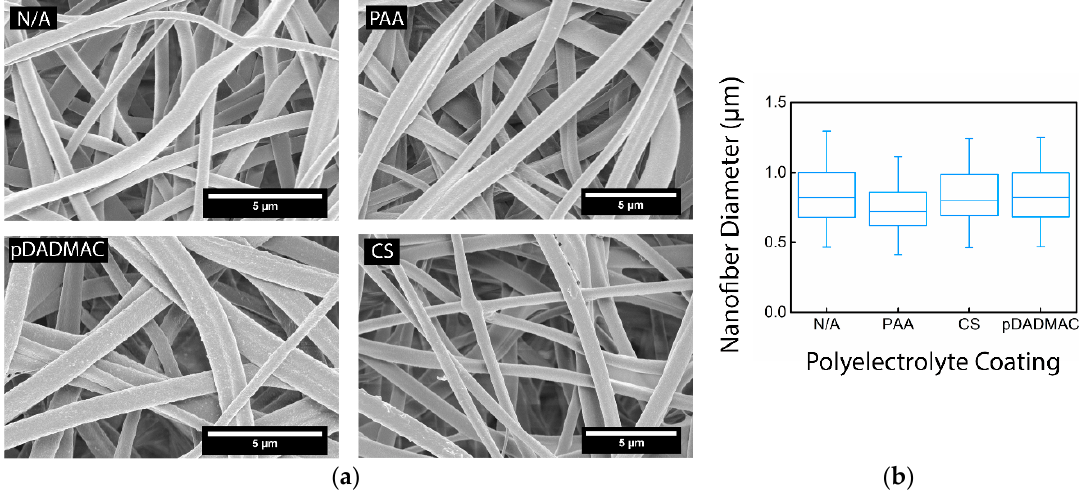
Figure 1. ( a ) SEM micrographs of electrospun cellulose nanofiber mats without functionalization (N/A) and functionalized with PAA, CS, and pDADMAC. All scale bars are 5 µm; ( b ) A box-and-whisker plot shows the median, lower and upper quartile, and the minimum and maximum value for the nanofiber diameter distribution for the cellulose nanofiber mats without functionalization (N/A) and functionalized with PAA, CS, and pDADMAC. All nanofiber mats had a statistically equivalent average fiber diameter. N = 3 nanofiber mats to confirm nanofiber morphology. Fiber diameter distribution was determined by measuring 50 random fibers from 5 micrographs. Table 1. Summary of the materials properties of polyelectrolyte-functionalized electrospun cellulose nanofiber mats.